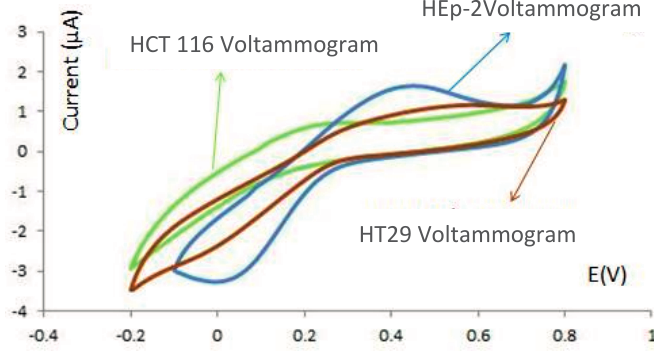
Figure 9. The voltammogram of HEp-2, HT29 and HCT 116 attached to sensor surface in K 3 [Fe(CN) 6 ] 1 mM in PBS (pH 7.4) vs.